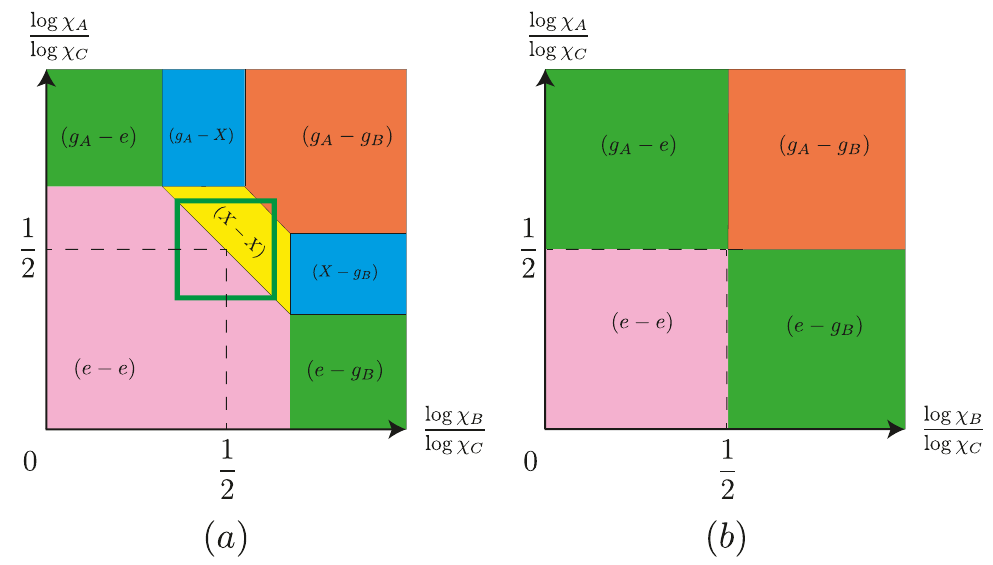
Figure 8 . (a): an illustration of the phase diagram in the saddle point limit for 2TN for generic values of m ≥ 2 , n ≥ 1 , χ as a function of log χ A and log χ B . The dominant elements in each phase log χ C log χ C are shown in a tuple as ( g ) . The green square roughly indicates the region of the phase diagram 1 , g 2 accessed by the TL limit. (b): as we take the limit log χ → 0 , the yellow and blue domains shrink log χ C in the phase